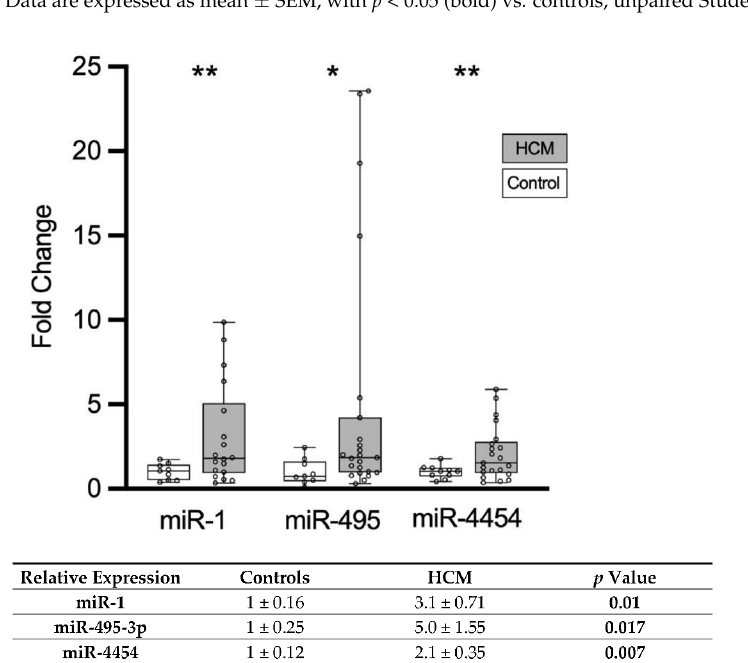
Table 2. Screening of circulating miRNAs in hypertrophic Cardiomyopathy (nCounter). The absolute fluorescence counts of circulating miRNAs are shown. Of the 800 miRNAs quantified, six miRNAs exhibited higher plasma levels in patients with hypertrophic cardiomyopathy than in the healthy control individuals. miRNA Controls HCM p Value miR-1 31 ± 3